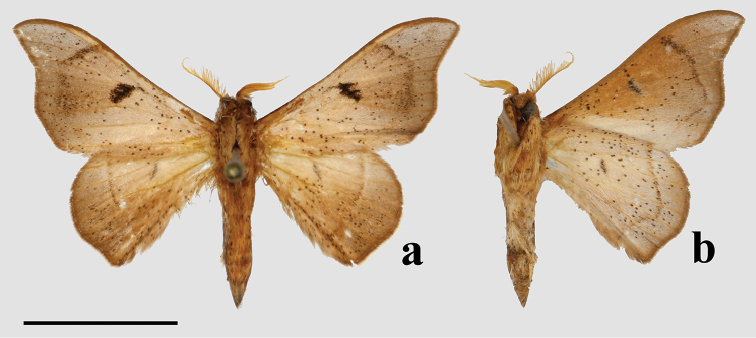
Adult male specimen of Lepismallamontagnaniaea dorsal b ventral. French Guiana, Piste Bélizon, km 27 [photo A Giusti] (NHMUK). Scale bar: 1 cm.